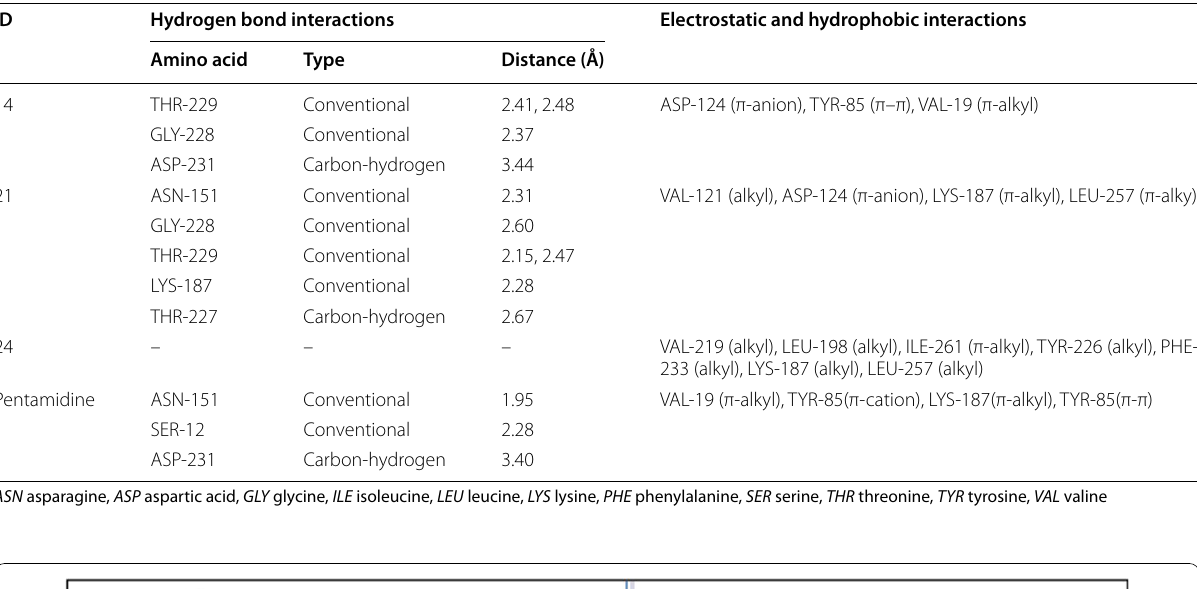
Table 10 Predicted binding interaction profile of selected template molecules with PdxK receptor